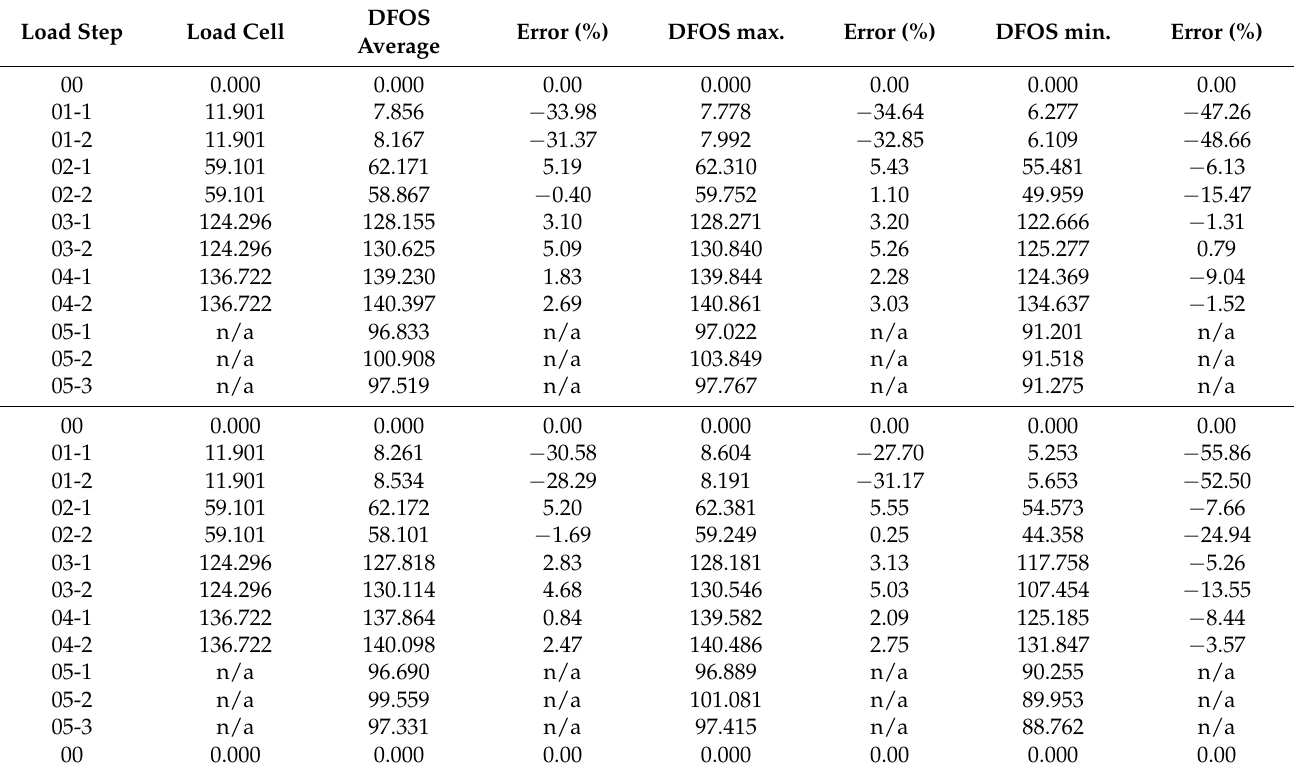
Table 9. Prestressing force monitored by load cell and DFOSs for PC3-2 (unit: